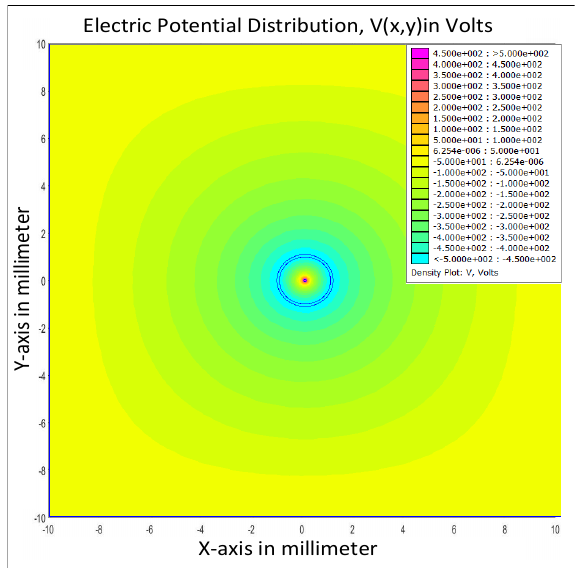
Figure 8. The electric potential distribution of the proposed device when (cid:101) r = 10.